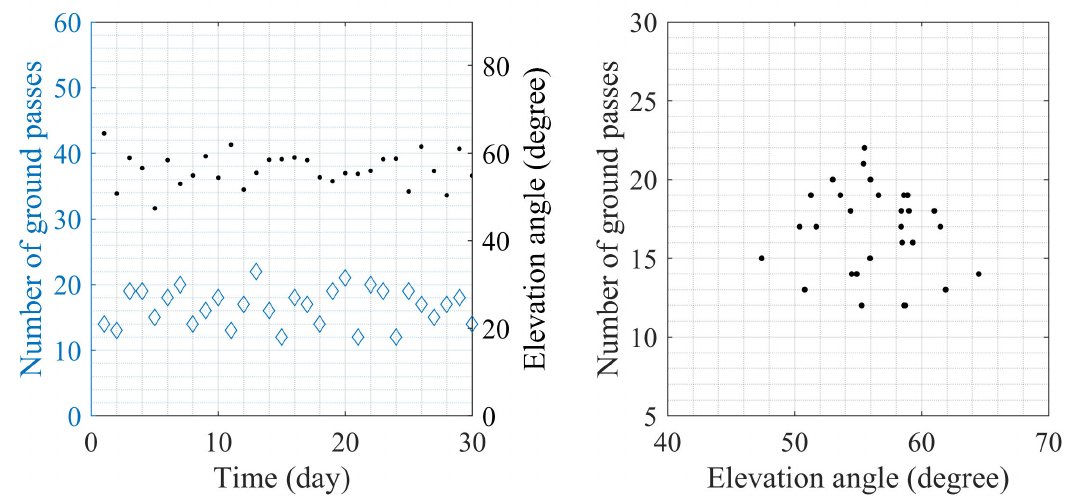
Figure 15. Number of ground passes and their average elevations for KITSUNE in GST countries for one month.